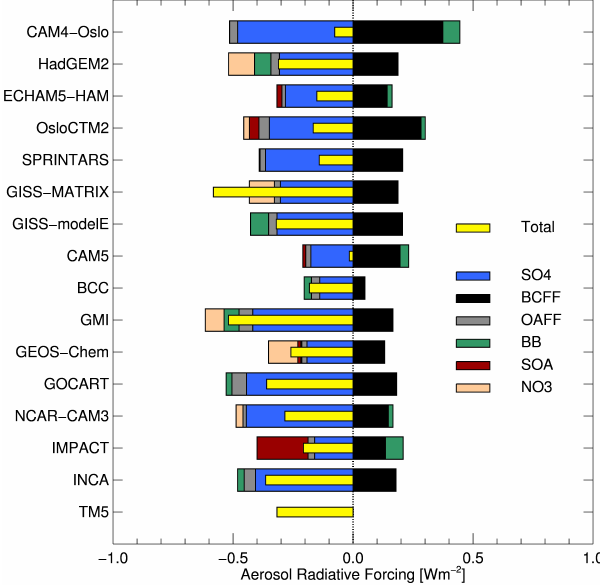
Fig. 4. Radiative forcing from the six components, overlain with the (unmodified) model total forcing (yellow